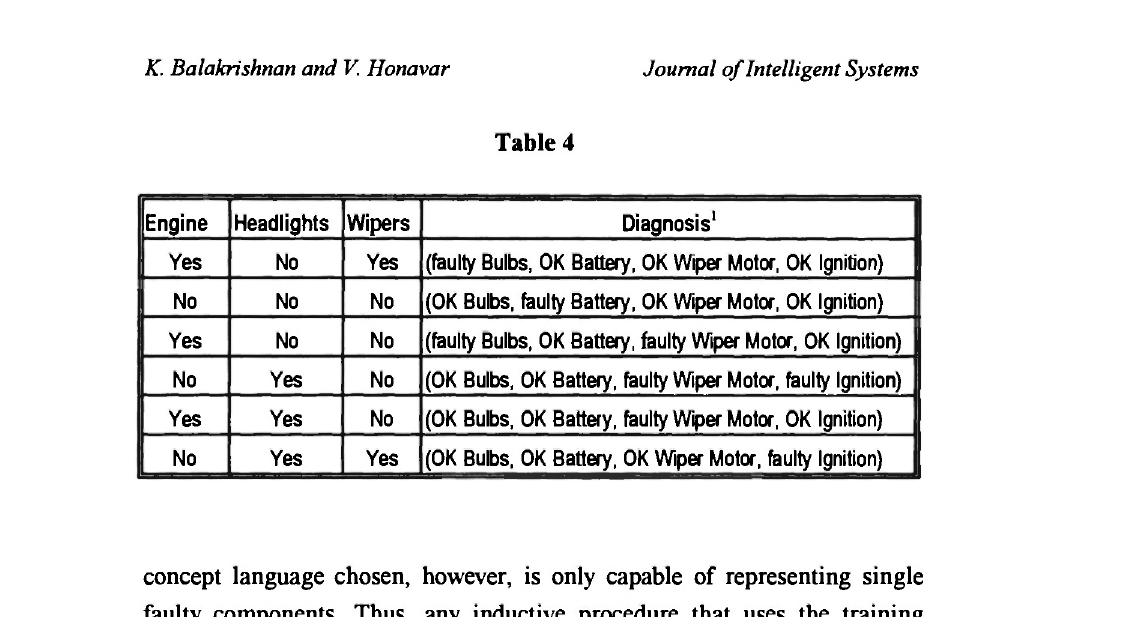
Engine Diagnosis